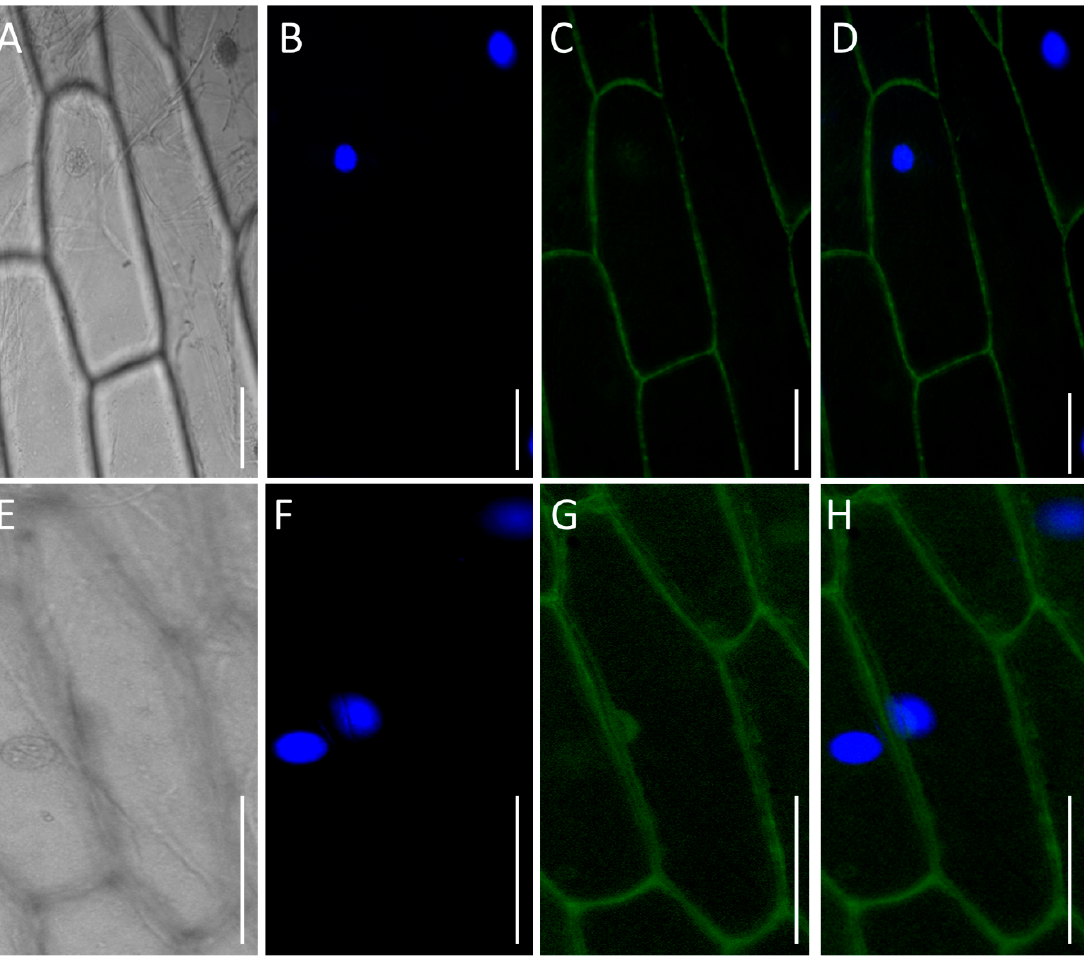
Figure 6. Subcellular localization of TaPT29-6A/GFP protein. Images showing onion epidermal cells expressing TaPT29-6A/GFP ( A – D ) and empty vector ( E – H ). Bright field illumination ( A , E ); DAPI-stained nuclei ( B , F ); UV excited fluorescence images ( C , G ); merged images of DAPI and fluorescence ( D , H ). Scale bar = 25 µm.